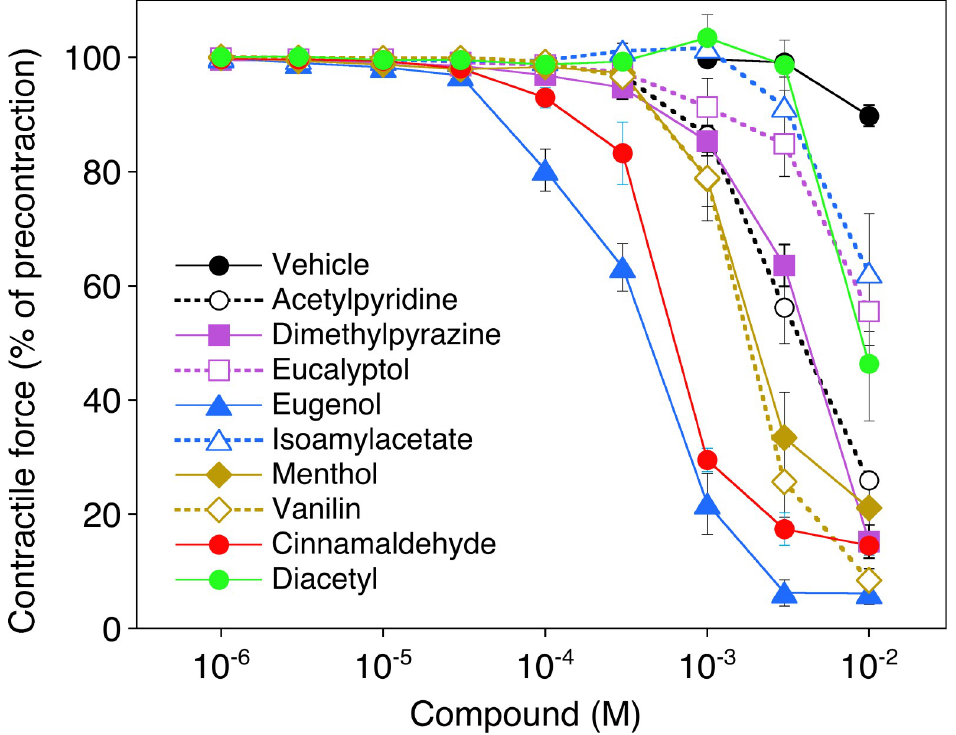
Fig 7. Effects of flavorings on vascular tone. The concentration-response to the various compounds (1 μ M—10 mM) or vehicle (DMSO) was measured with U-46619 precontracted aortic rings. Concentration-response curves obtained with different ring segments from a single animal were averaged and counted as an individual experiment. Data are expressed as mean values ± SEM (n = 6).